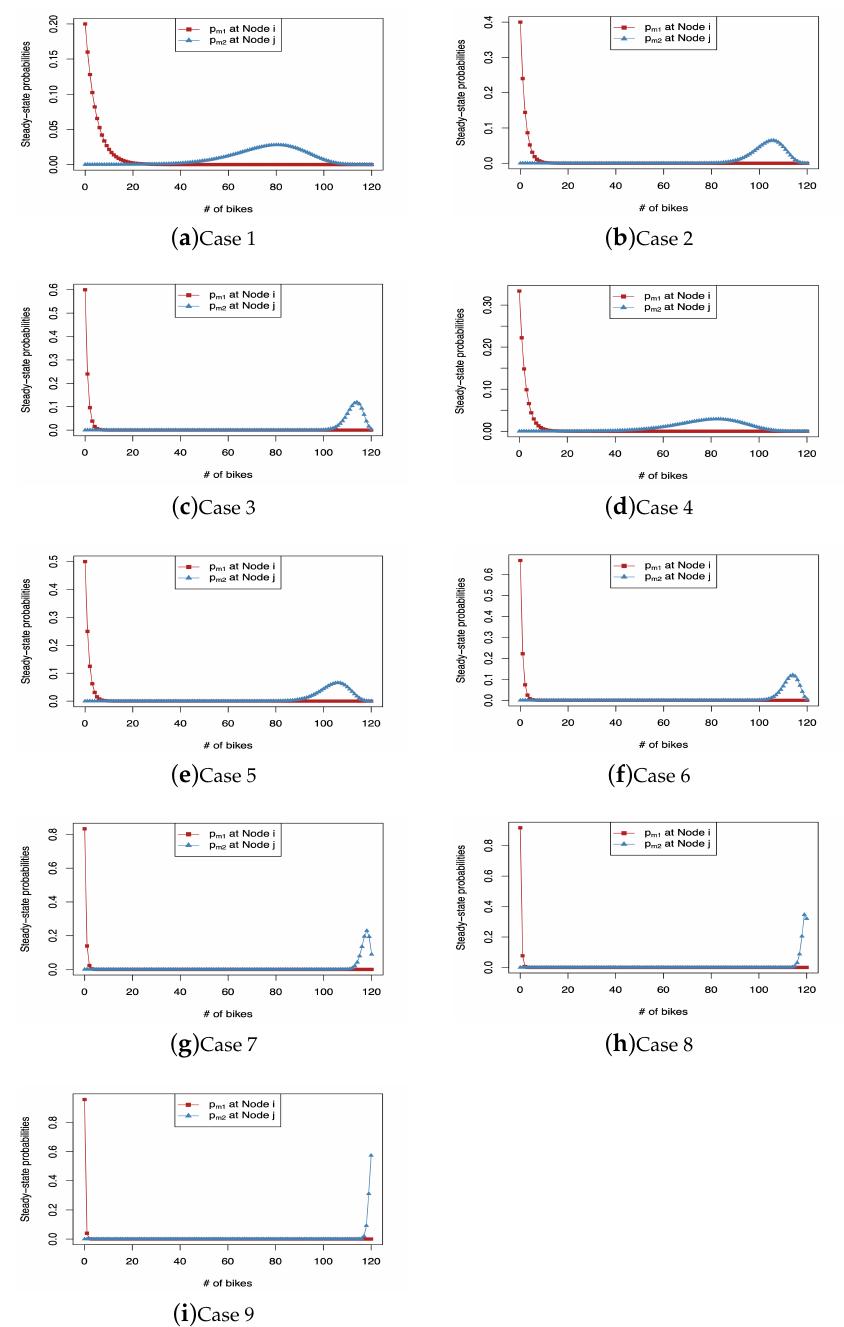
Figure 5. Probabilities with respect to the number of bikes at nodes i and j